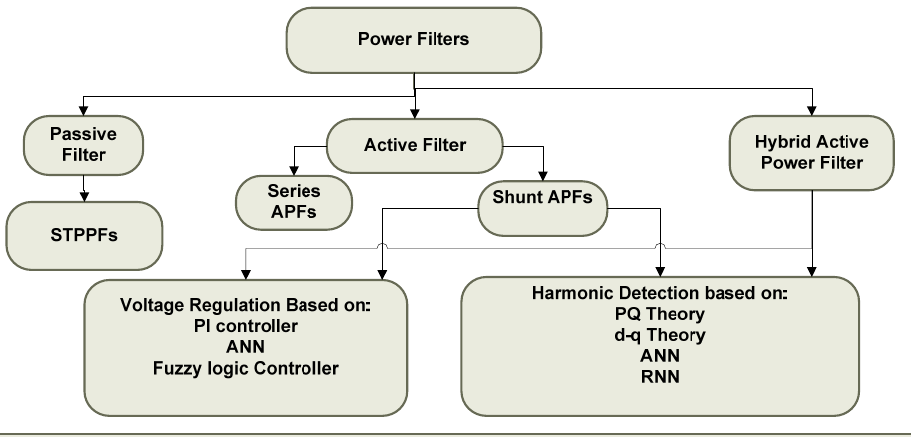
Figure 2. Literature overview of harmonic power filters [4–30].